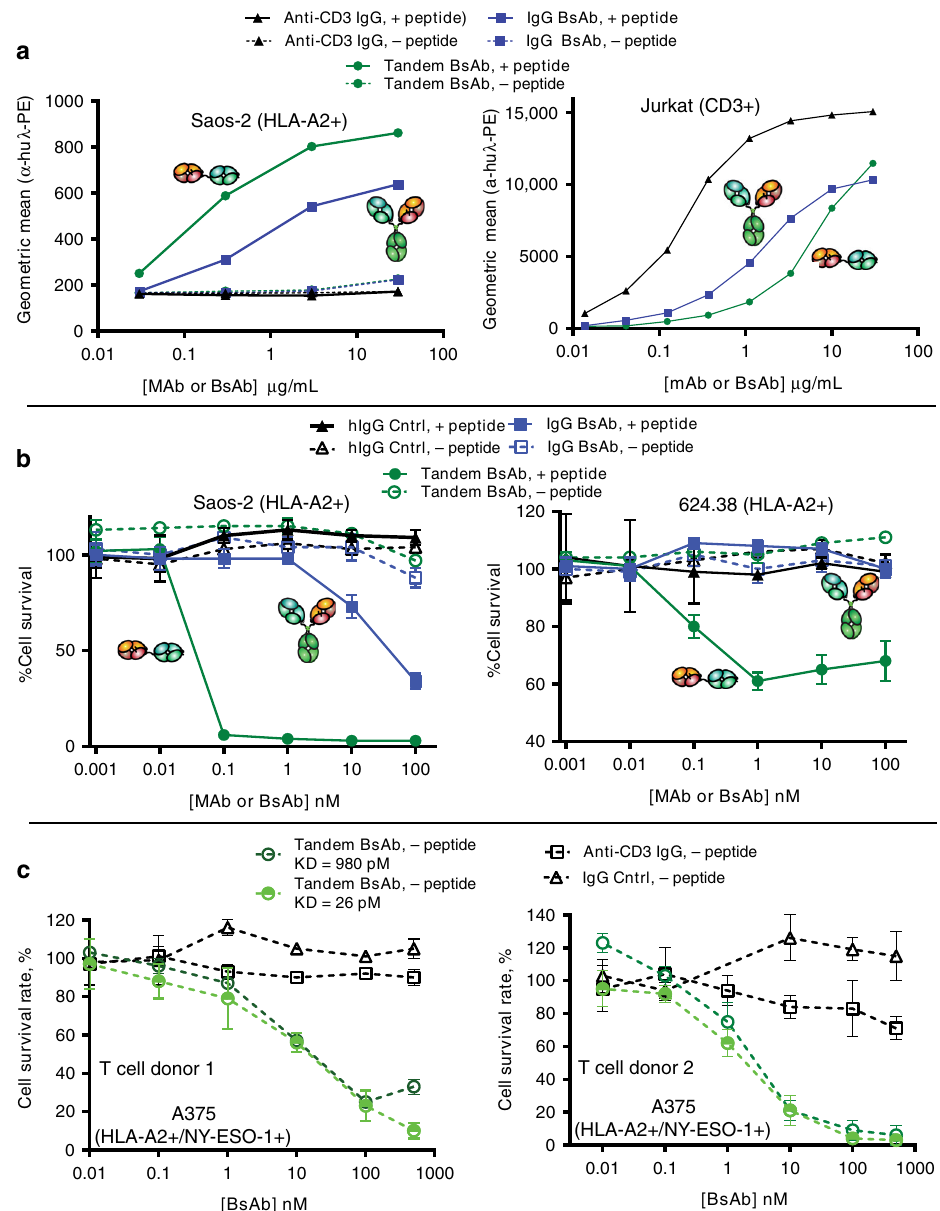
Fig. 7 Cell binding and T cell redirected killing properties of the TCR/CD3 BsAbs. a Flow cytometry cell binding titrations of the BsAb molecules with HLA-A2 + Saos-2 tumor cells with or without pulsing of the NY-ESO-1 peptide SLLMWITQC (left) and with CD3 + Jurkat cells (right). Each data point is the Geometric mean of the fl uorescence of the cells labeled with the CD3 mAb or TCR/CD3 BsAb and secondary antibody. b T cell redirected killing of HLA- A2 + Saos-2 (left) and 624.38 (right) tumor cells facilitated by TCR/CD3 BsAbs with and without pulsing with exogenous NY-ESO-1 peptide. c TCR/CD3 tandem BsAb-mediated T cell redirected killing of A375 HLA-A2 + /NY-ESO-1 + melanoma cells (no addition of exogenous peptide). Panels to the right and left use T cells expanded from different donors. For plots in sections ( b ) and ( c ), the data points are the mean of three replicates and the error bars are the standard deviation. Source data are available in the Source Data fi Differential scanning fl uorimetry and calorimetry . Protein unfolding was binding buffer (20 mM Tris-HCl pH 8.0, 0.5 M NaCl) at a fl ow rate of 1mL/min monitored on the Lightcycler 480II RT PCR machine (Roche) using SYPRO Orange for 1mL columns and 5mL/min for 5mL columns, respectively. After passing the dye (Invitrogen, S6651). Excitation and emission fi lters were set at 465nm and CHO expression supernatant over the column to capture the His-tagged TCRs or 580nm, respectively. The temperature was ramped from 25°C to 95°C at a rate of TCR fragments, the TCR proteins were eluted with ten column volumes of elution buffer (20 mM Tris-HCl pH8.0, 0.5M NaCl, 250 mM Imidazole). Imidazole was later removed by passing the proteins through a preparative size exclusion column running buffer. The experiment was performed by diluting the proteins to 0.4mg/ (SRT-10C SEC300) or via dialysis against a phosphate buffered saline solution ml and diluting Sypro 250-fold, then combining the diluted protein and Sypro in (PBS) at pH 7.2 – 7.4 using VIVASPIN 6 concentrators with a 10,000 MW cutoff. equal parts in a 96-well plate ( fi nal volume: 30 μ L per well). The samples were IgG-Fc containing proteins were puri fi ed using mAbSure resin (GE Healthcare) divided into 6 μ L triplicates on a 384-multiwell assay plate (Roche, 04-729-749-001). and preparative size exclusion. Sodium dodecyl sulfate polyacrylamide gel The midpoint of thermal unfolding ( T m ) determination for each protein was electrophoresis (SDS-PAGE) was performed using 4 – 12% Bis Tris gels according to the manufacturer (Life Technologies). Reductions and alkylations were performed performed on the LightCycler Thermal Shift Analysis Software (Roche) using the fi rst derivative method. The analysis software smoothed the raw fl uorescence data with 1 mM dithiothreitol (DTT) and 1mM N -ethylmaleimide (NEM).